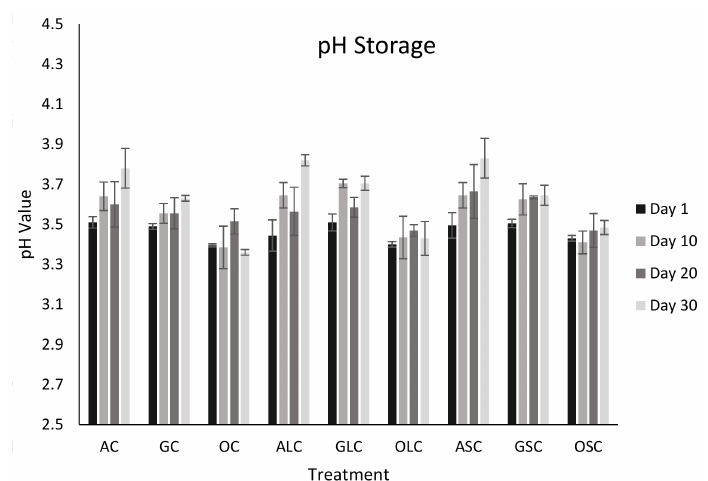
Figure 2. pH values of various fruit juice samples over 30 days of refrigerated storage. AC, GC, OC (apple, grape, and orange juice control); ALC, GLC, OLC (orange, grape, and orange juice with long chain inulin fiber); ASC, GSC, OSC (apple, grape, and orange juice with short chain inulin fiber).